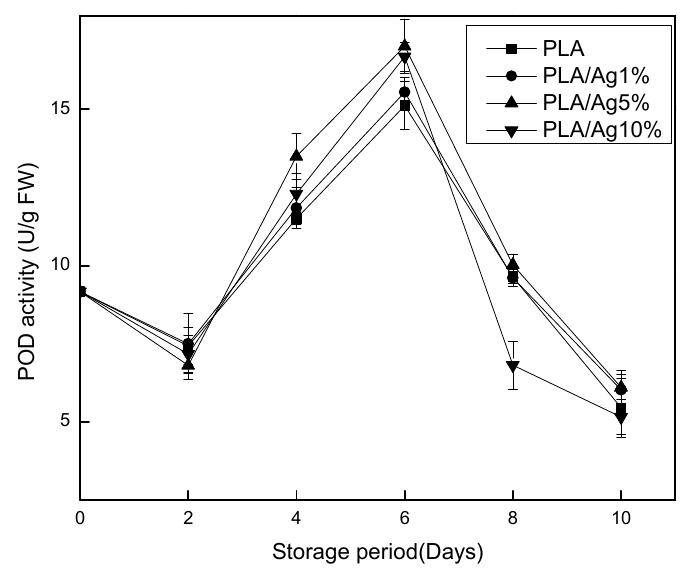
Figure 7. Effect of different concentration of nano-Ag active packages on the activity of POD of strawberry stored at 4 ± 1 °C for 10 days. Data are presented as mean ± standard deviation.